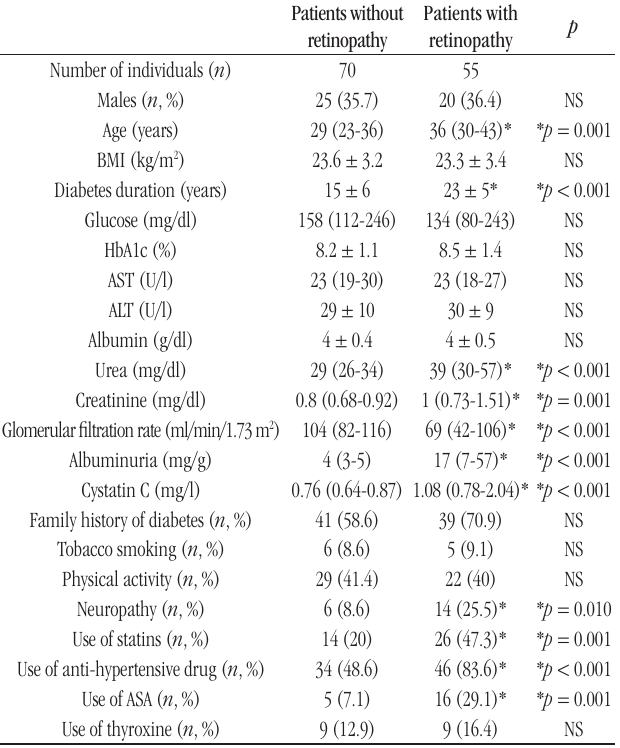
taBLE 1 − Characteristics of type 1 diabetes patients classified according to presence or absence of retinopathy